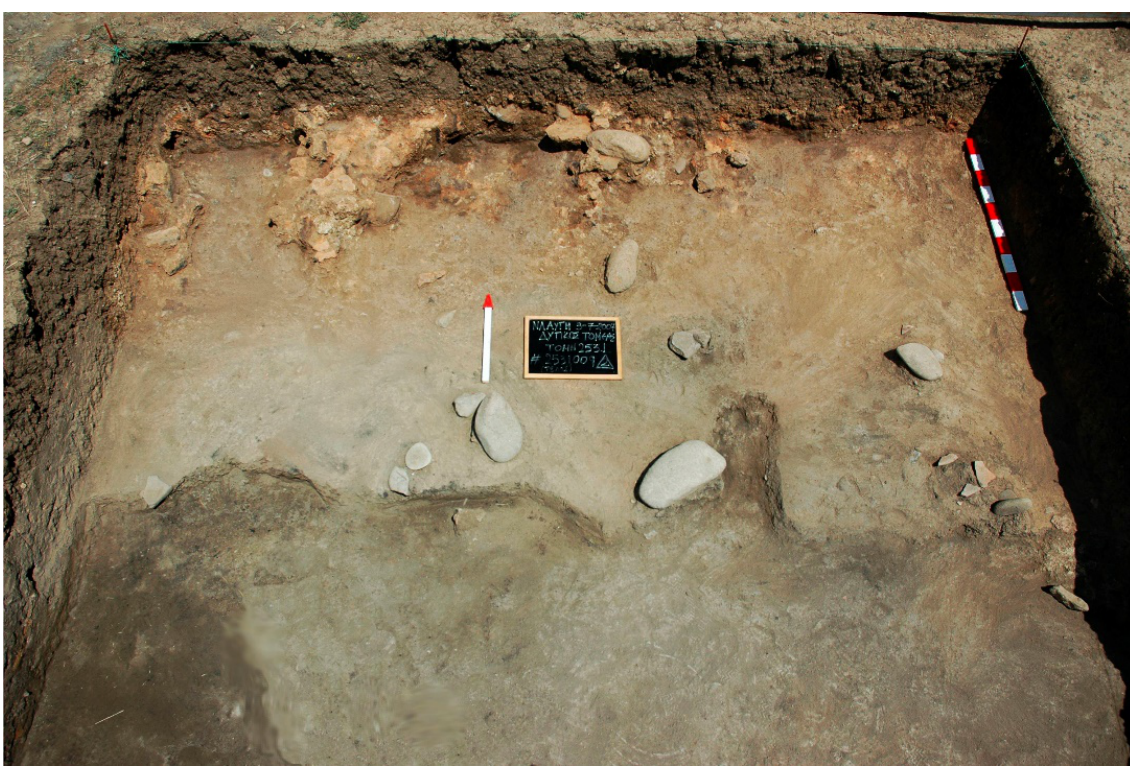
Figure 12. Open area (AVGI I) with in situ grinding